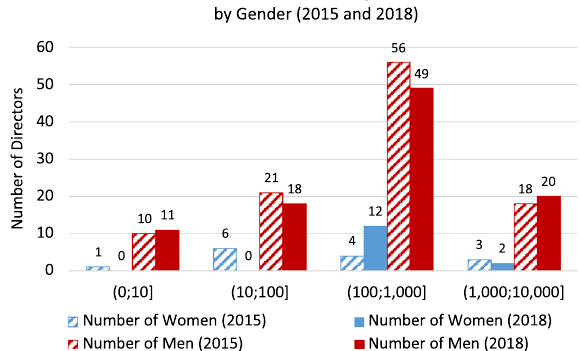
Fig. 8 Distribution of Betweenness Centrality for Directors with BC > 0 by Gender (2015 and 2018)